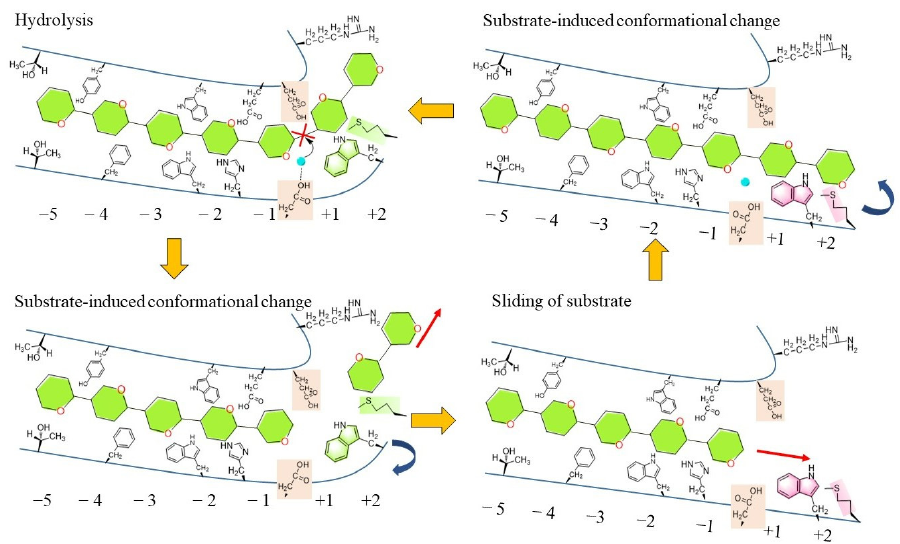
Figure 3. The hypothetical model of the processive action of GH48 cellulases [27,54]. The sugar moieties of cellulose are represented by green hexagons. The catalytic acid and base are shown in light orange shades, the nucleophilic-attacking water molecule is drawn as a blue sphere. Two important residues (Trp417 and Met414 as in Cel48F) contributing to the conformational changes are colored green (hydrolyzing conformation) and pink (sliding conformation), respectively. Some of the residues consisting of the channel are also indicated. The figure was prepared in Microsoft PowerPoint with molecular structure pictures generated by ChemDraw (PerkinElmer).